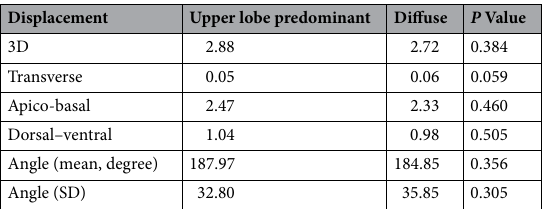
Table 2. Results of univariate analysis between upper lobe predominant and diffuse type emphysema.